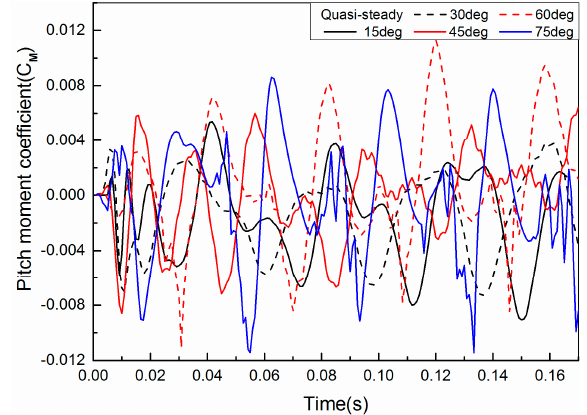
Figure 14. Time history of the wing pitching moment coefficient calculated by the quasi-steady method.